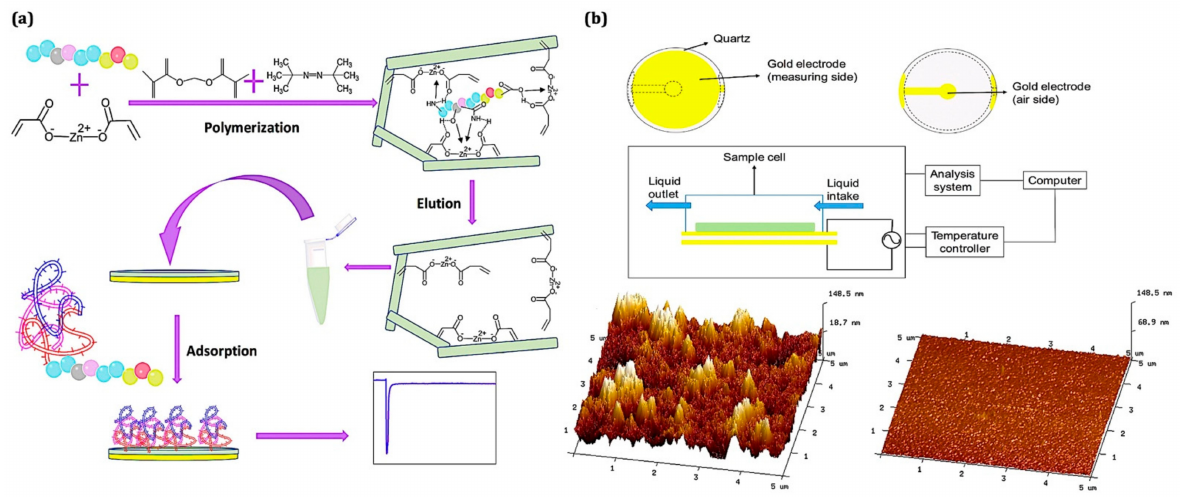
Figure 4. ( a ) Design of epitope-imprinted QCM biosensor; ( b ) bare QCM chip and AFM measurement results. Reprinted with permission from ref. [151]. Copyright 2017